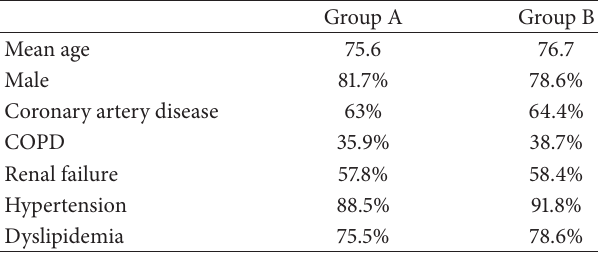
Table 1: Demographic characteristics of the two study groups.